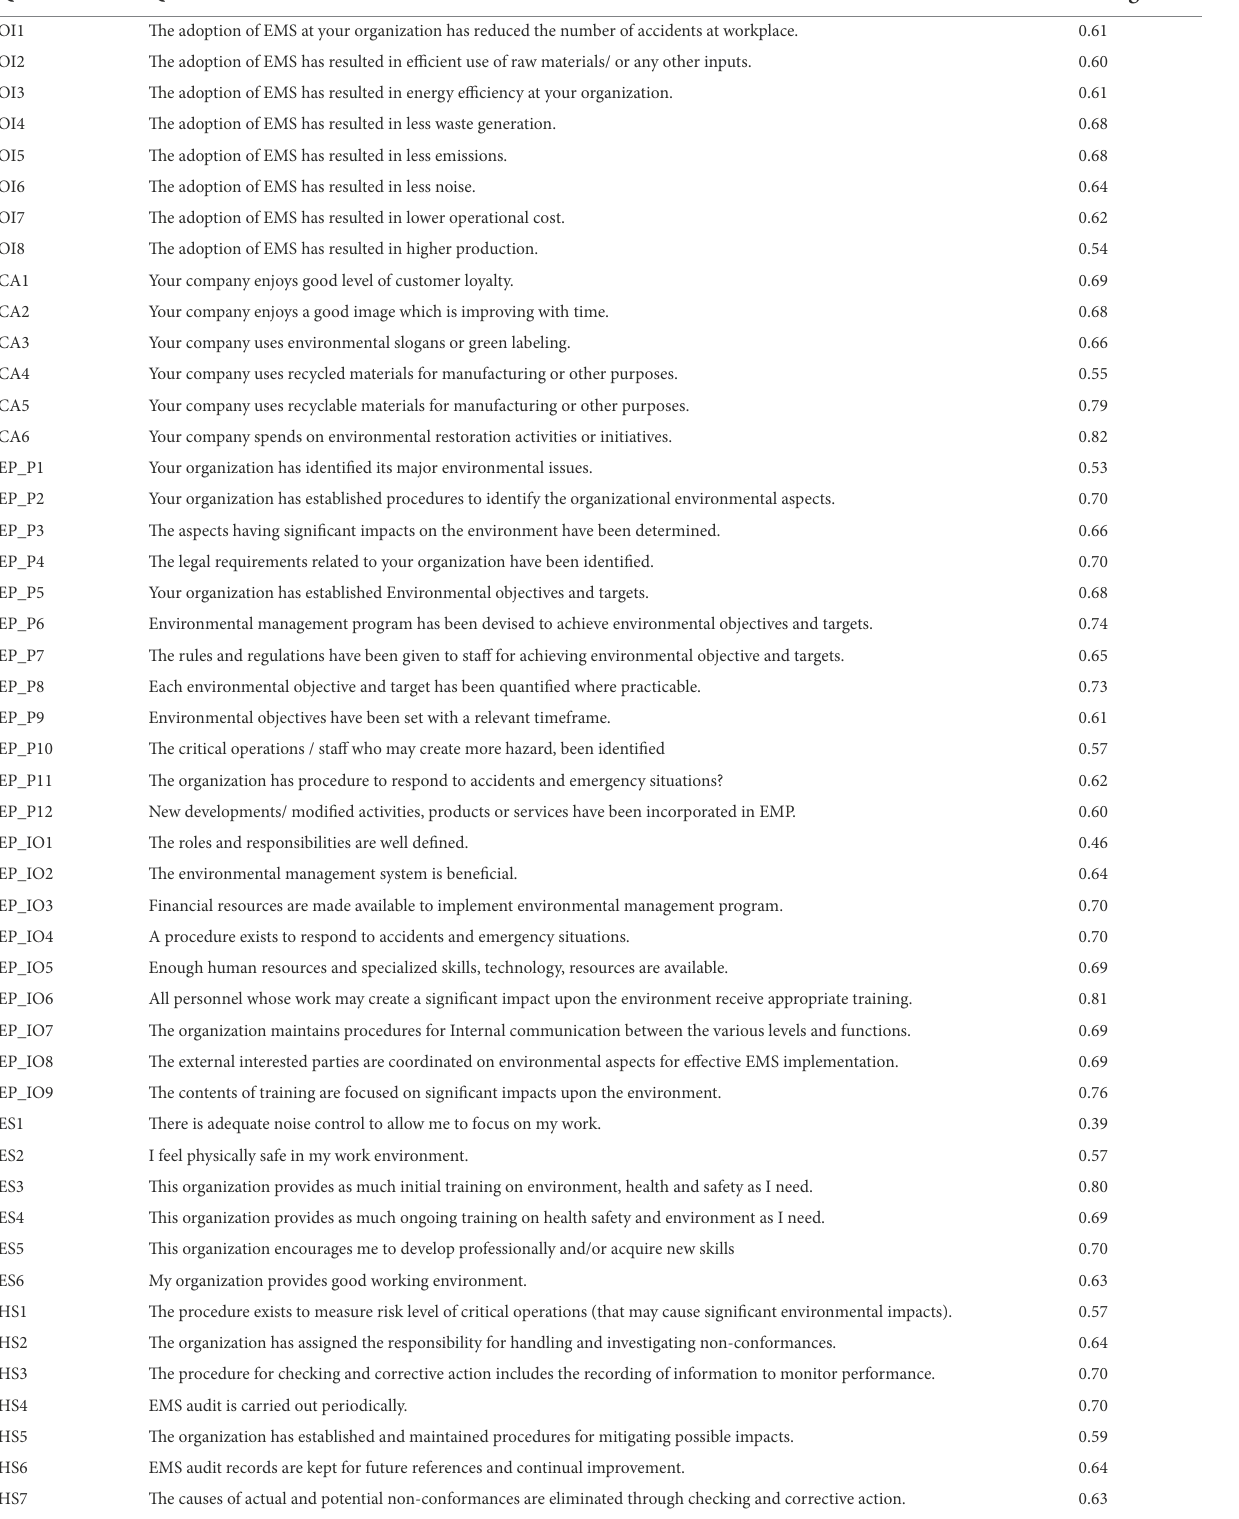
TABLE 1 Factor loadings of principal component